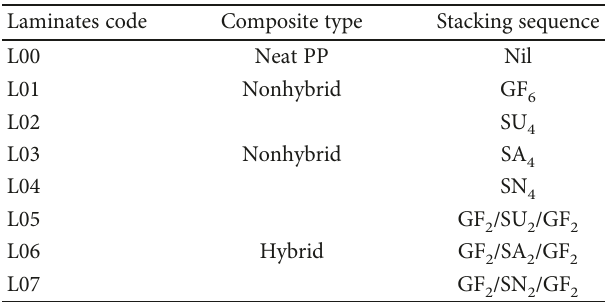
Figure 3: Prepreg of (a) SPF/PP with uniform fi bre distribution and (b) kenaf/PP prepreg [28]. Table 1: Stacking sequence of the nonhybrid and hybrid